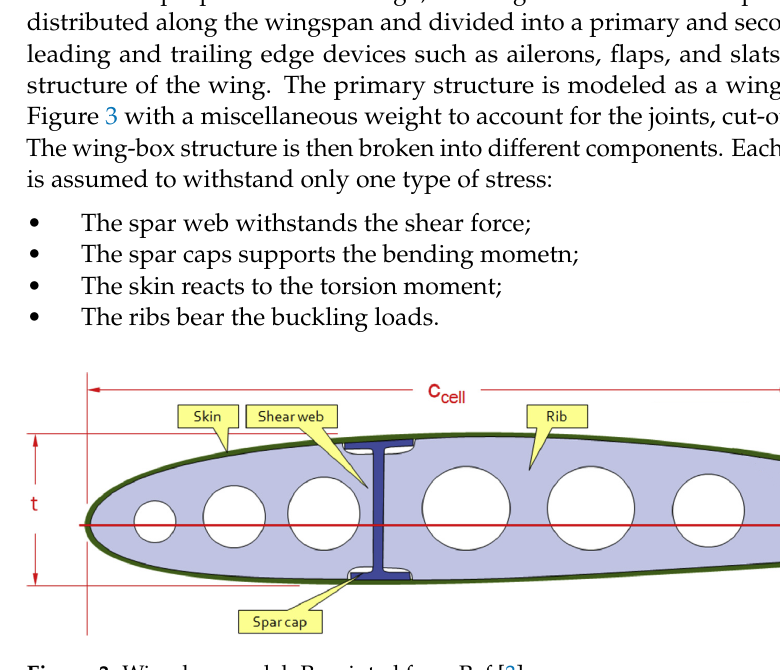
Figure 3. Wing-box model. Reprinted from Ref